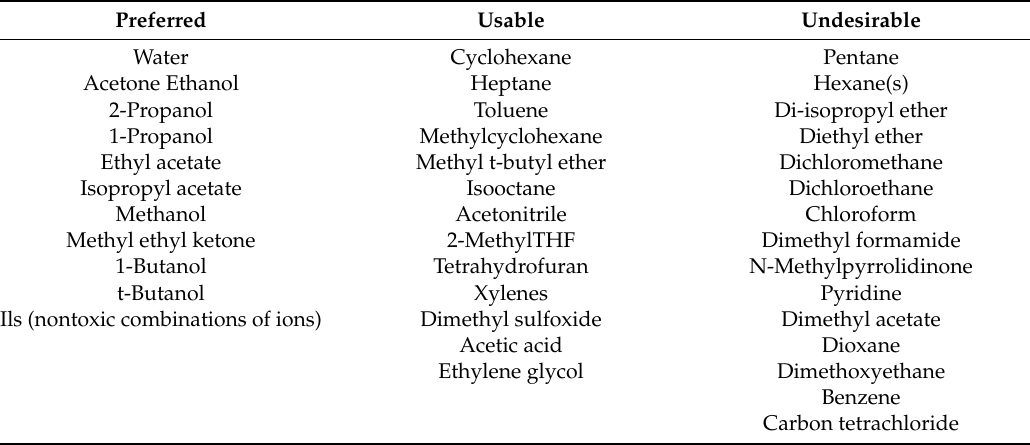
Table 1. Solvent selection